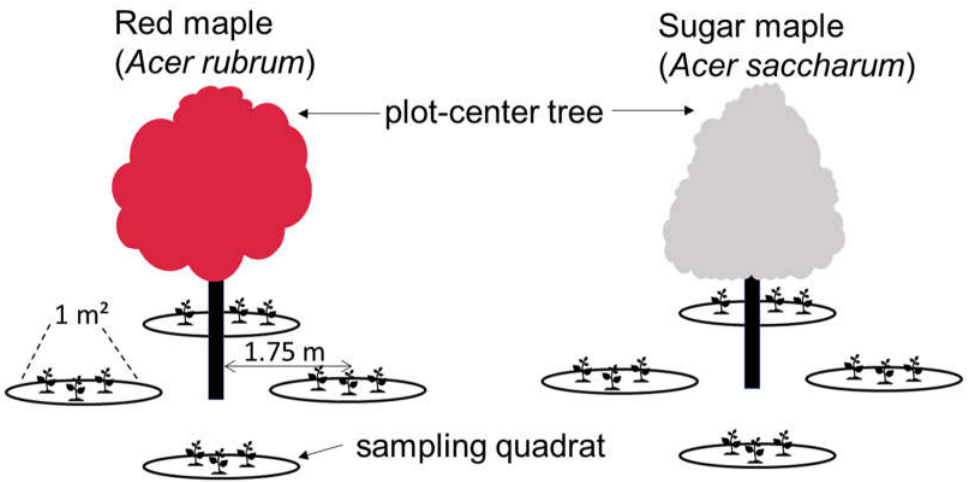
Figure 2. Experimental design of plot pairs at each site (replicated nine times in each watershed) for collecting herb-layer composition and cover.